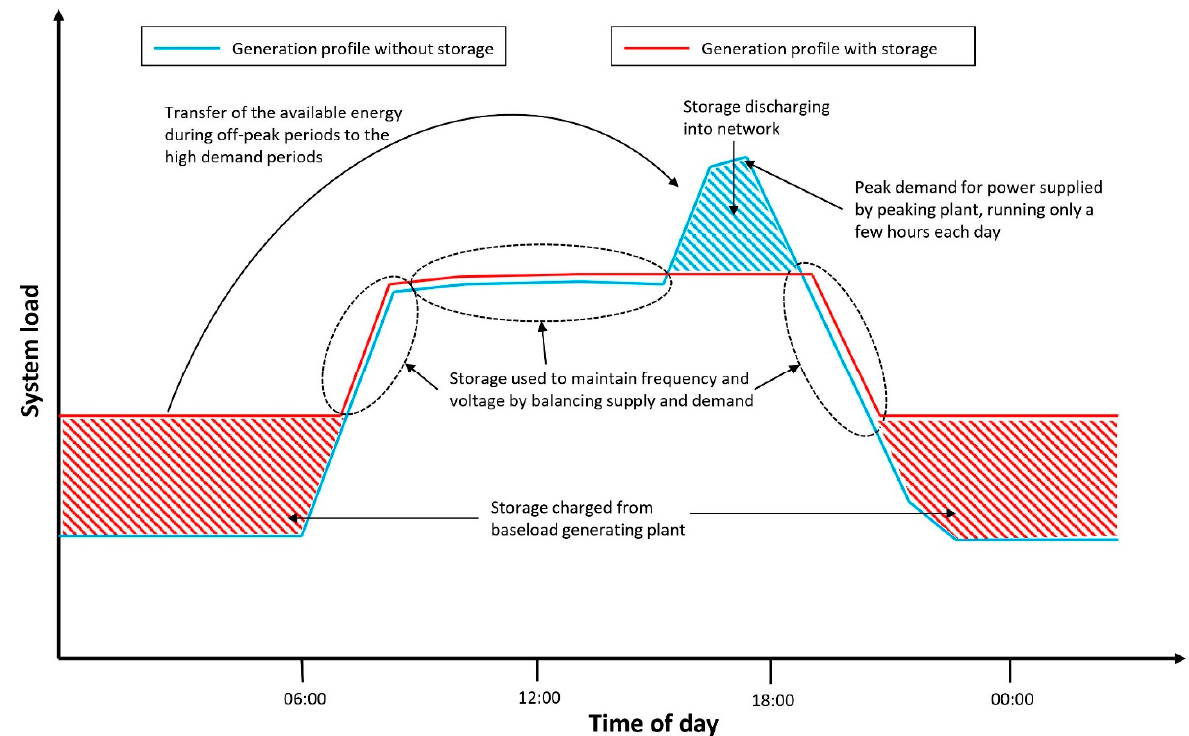
Figure 1. Load demand profile with energy storage systems